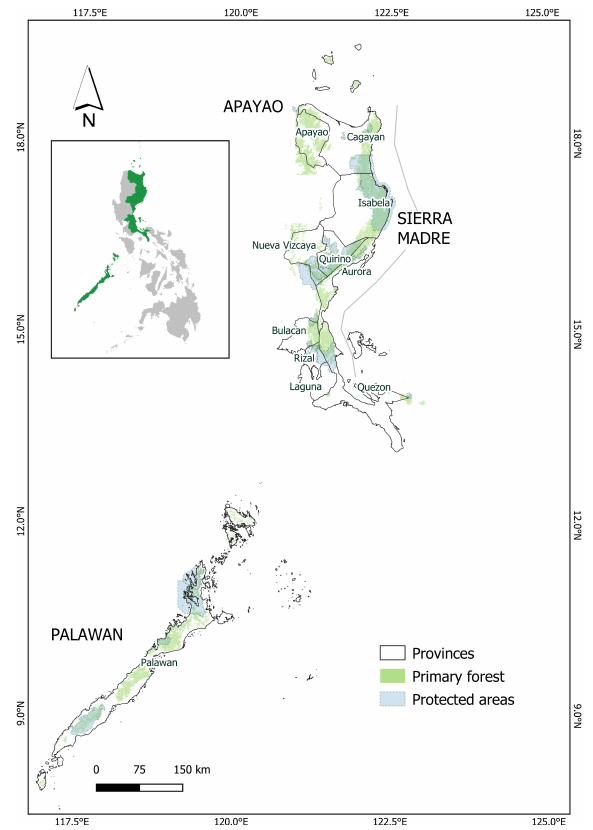
Figure 1. Study area map showing the Philippines as inset and the provincial boundaries of Palawan, Apayao, and several provinces within the Sierra Madre mountain range. The overview of the country’s primary forest in 2019 (derived from the method of [30]) and the state-declared protected areas are also shown.